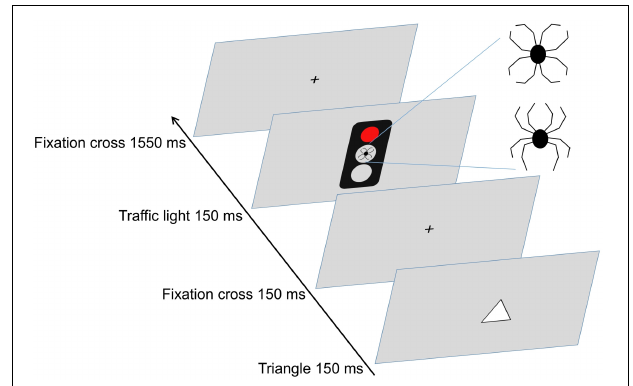
FIGURE 1 | The triangle is presented in the middle of the screen for 150 ms. The color of the traffic light indicates whether the subject is required to press (Go signal) one of the two buttons according to the orientation of the triangle or to withhold from responding (No-go signal). Emotionally neutral or threatening distractor is shown in the centermost circle of the traffic